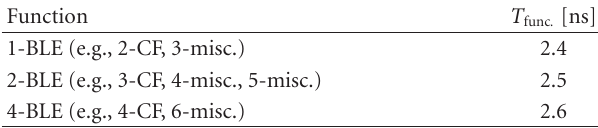
Table 3: Implementation parameters for